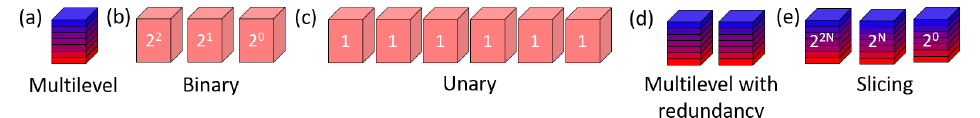
Figure 8. Programming mapping techniques. Conceptual representation of multilevel ( a ), binary ( b ), unary ( c ), multilevel with redundancy ( d ) and multilevel with slicing ( e ) programming. Adapted from